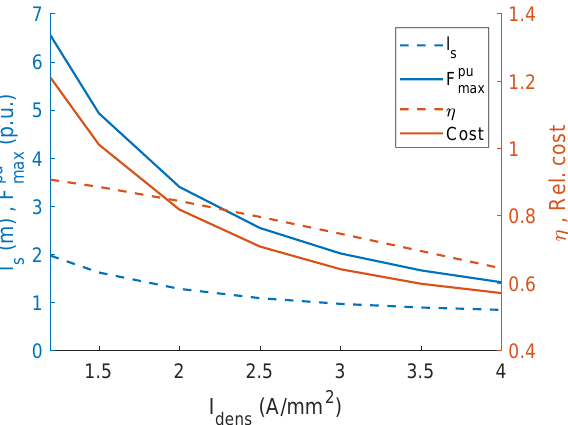
Figure 8. Stator length, maximum damping force in per unit, efficiency and relative cost for the original generator design with different values of the rated current density, I dens and an adjusted stator length, l s to achieve an output power of 18.4